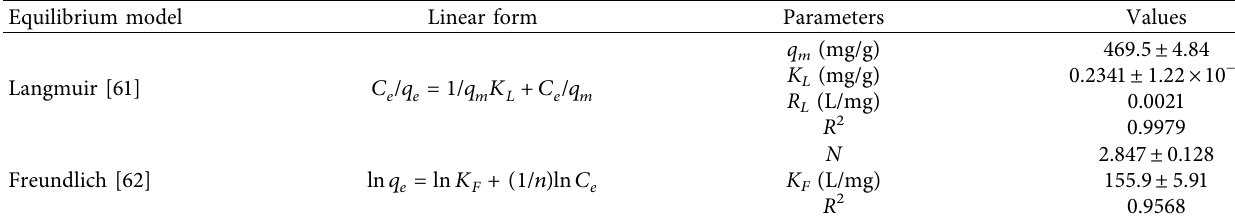
Table 2: Equilibrium isotherm models for Co (II) adsorption onto CaO.MgO nanosorbent. Equilibrium model Linear form Parameters